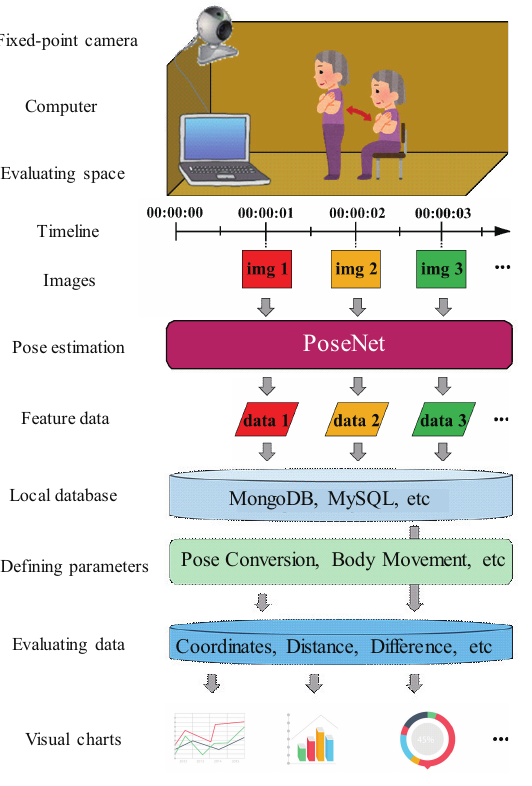
Figure 1. The overall architecture in the preliminary study.